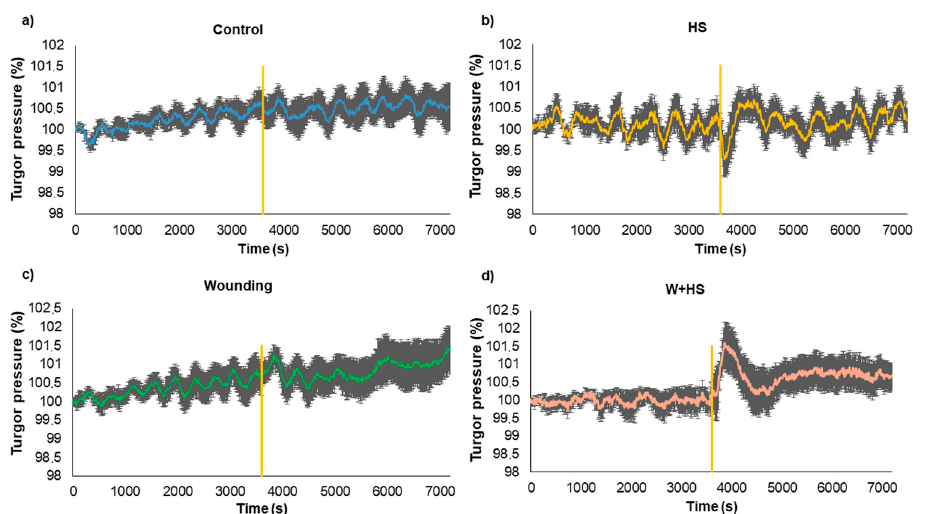
Figure 9. Measurements of the turgor pressure variation of systemic leaves over 2 h. Hydraulic pressure is represented as a percentage of the initial turgor pressure at 0 s. The stimuli ( a – d ) were applied after 1 h of measurement (represented by the vertical orange line). Each graph represents the average of 6 biological replicates (n = 6) and the standard deviation in each sampled point (time step = 10 s). Heat shock (HS), wound (W), and combined stimuli (W+HS). The average coefficients of variation are shown for the data before (C.V.B) and after (C.V.A) stimulation.